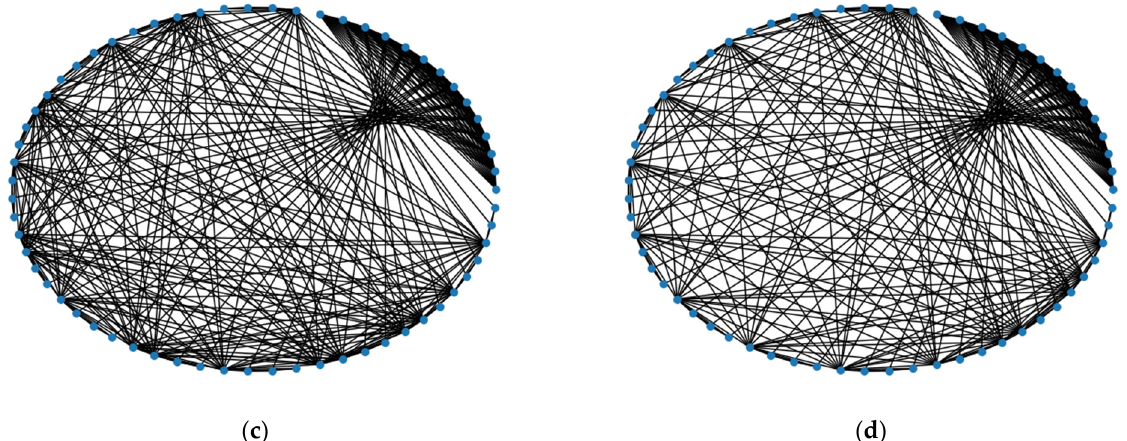
Figure 1. The network model of C2 system. ( a ) Network A; ( b ) Network B; ( c ) Network C; ( d ) Network D.